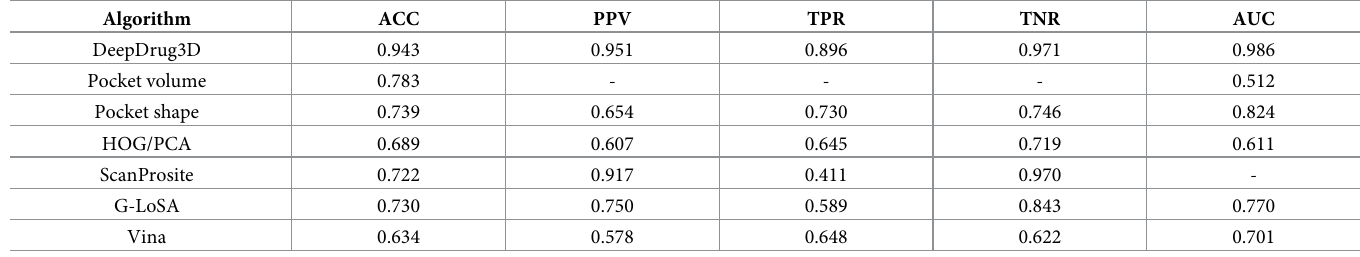
Table 1. Performance of various algorithms to classify nucleotide-binding sites. DeepDrug3D is compared to volume- and shape-based approaches, a classifier employing the histogram of gradients with principal component analysis (HOG/PCA), pocket matching with G-LoSA, molecular docking with Vina, and sequence signa- ture detection with ScanProsite. The performance is assessed with the accuracy (ACC), precision (PPV), sensitivity (TPR), specificity (TNR), and the area under the curve (AUC).